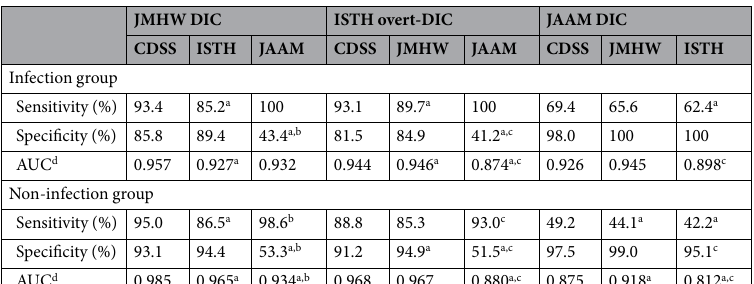
JMHW DIC ISTH overt-DIC JAAM DIC CDSS JMHW JAAM